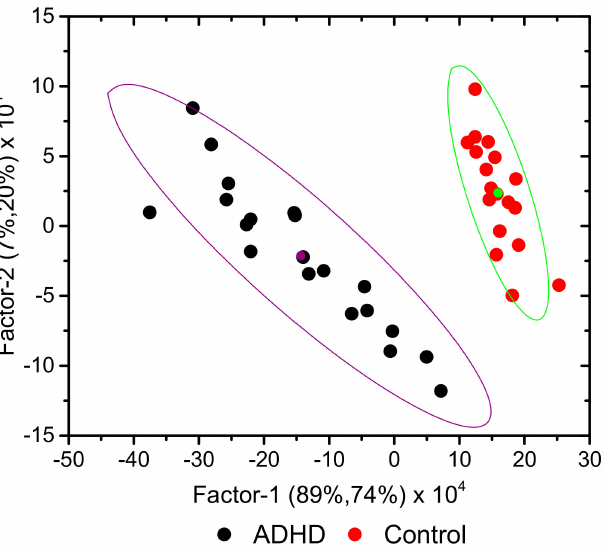
Figure 4. A 2D scores plot (Factor-1 vs. Factor-2) for the developed PLS-DA model, showing the 95% confidence ellipses. The points with the same color of the ellipses correspond to their centers and are the average point of the associated